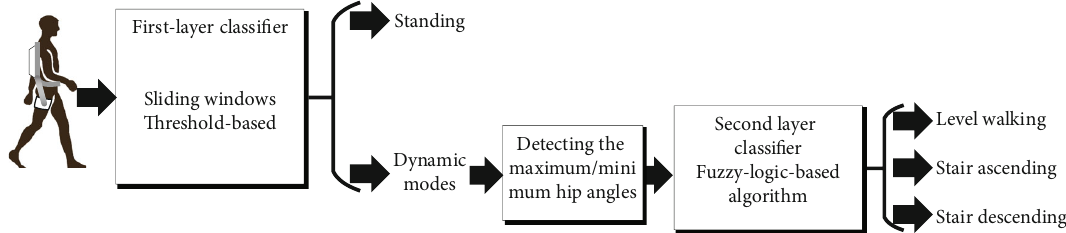
Figure 3: The diagram of the recognition method. The fi rst layer was to distinguish dynamic modes from standing (St). The second layer was designed to classify the dynamic modes, and there were three dynamic modes (LW, SA, and SD).